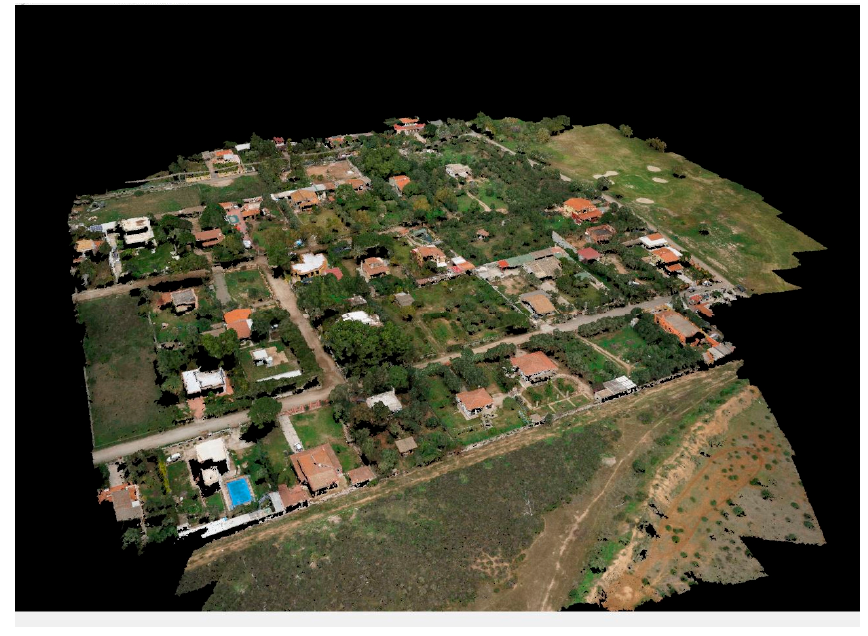
Figure 9. Pix4D mesh.